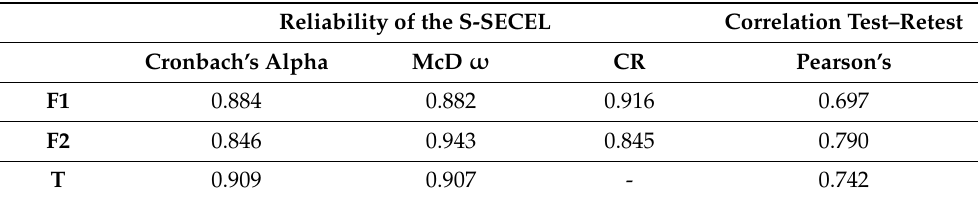
Table 6. Internal consistency reliability of S-SECEL and test–retest